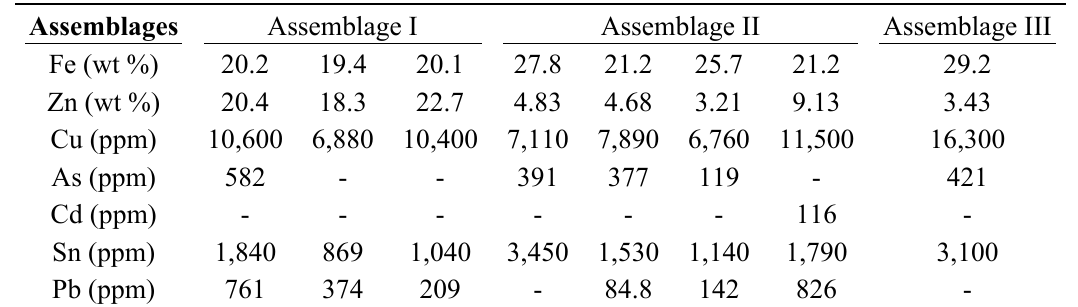
Table 6. by ED-XRF. “-” indicates non-detected.